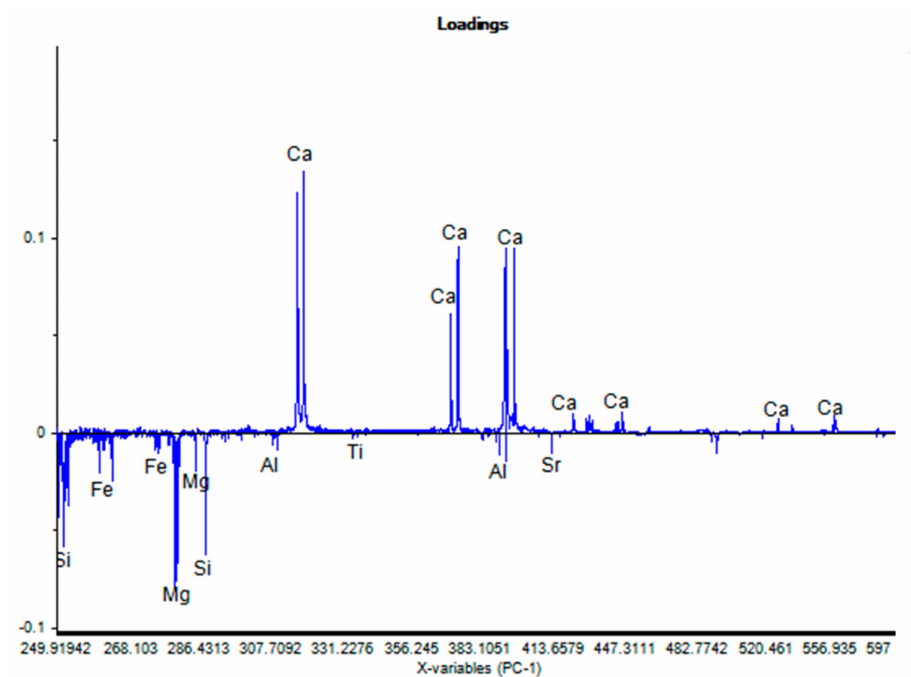
Figure 10. Loading plot for the principal component analysis of the LIBS spectral data.